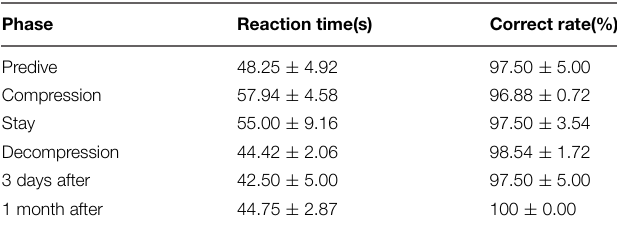
TABLE 1 | 2D mental rotation ability across different phases of the experiment ( ¯ X ± SD, n = 4).